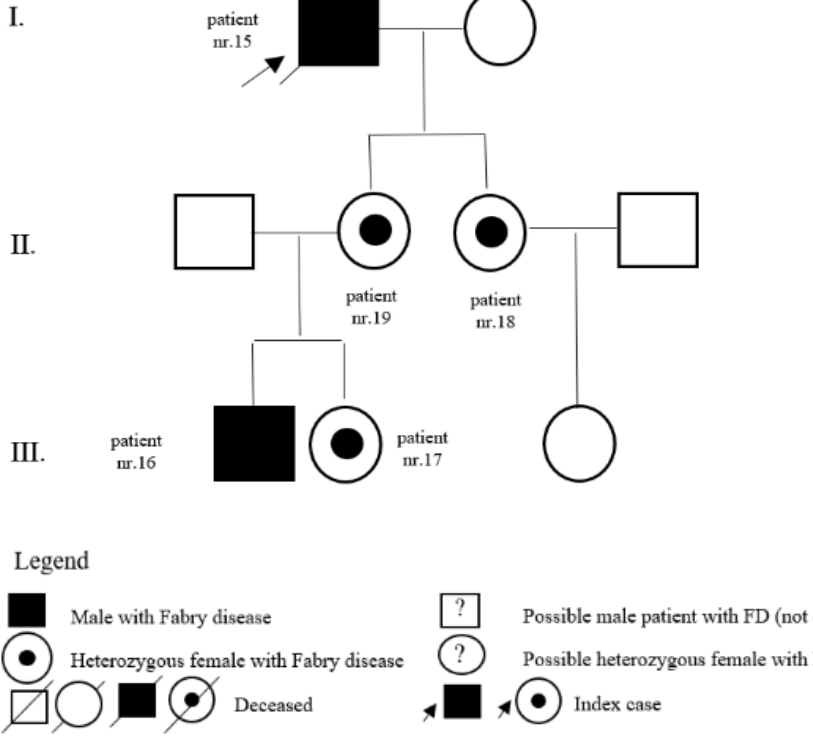
Figure 4. Pedigree of family with mutation c.98A>G.